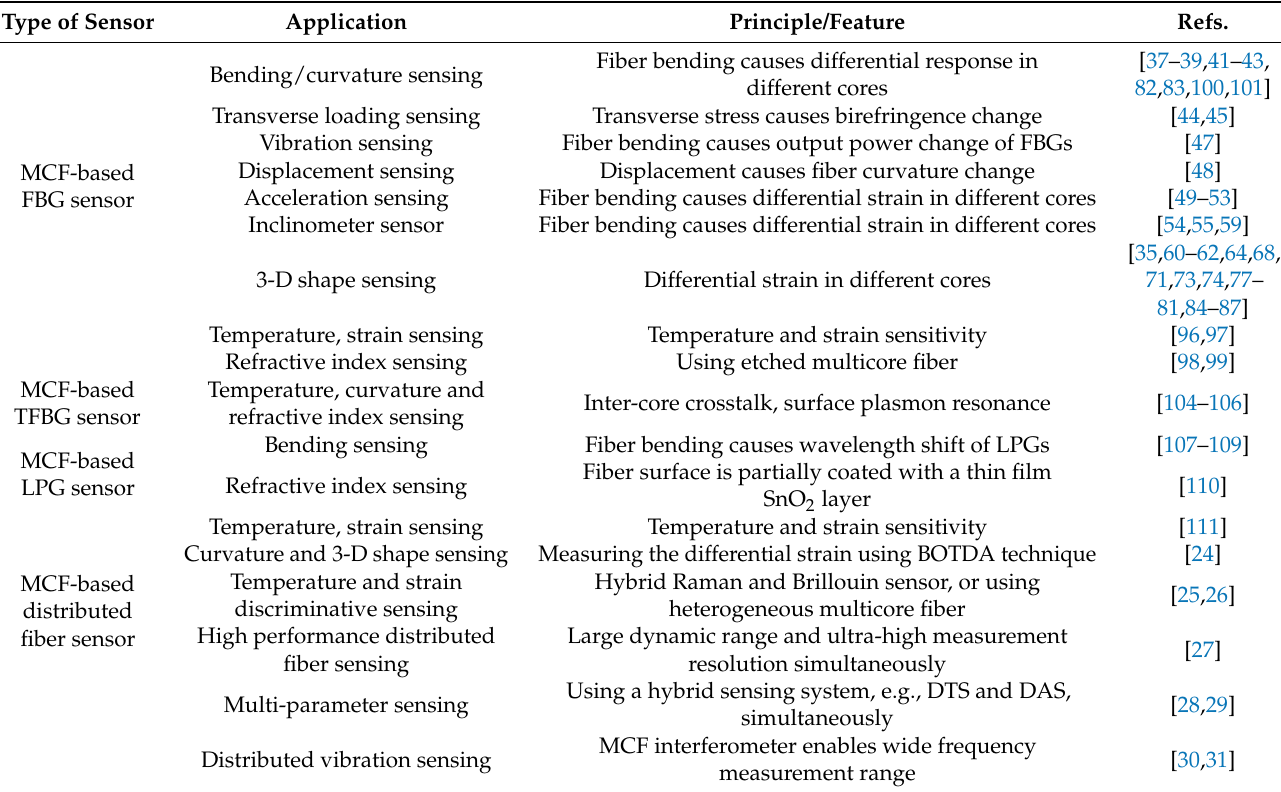
Table 1. Summary of different multicore fiber